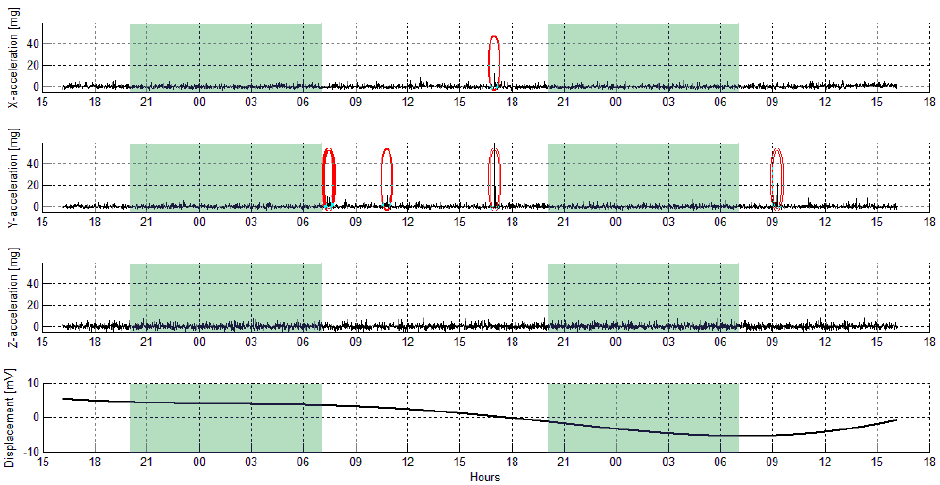
Figure 15. Results registered by node 4 (2-day interval).